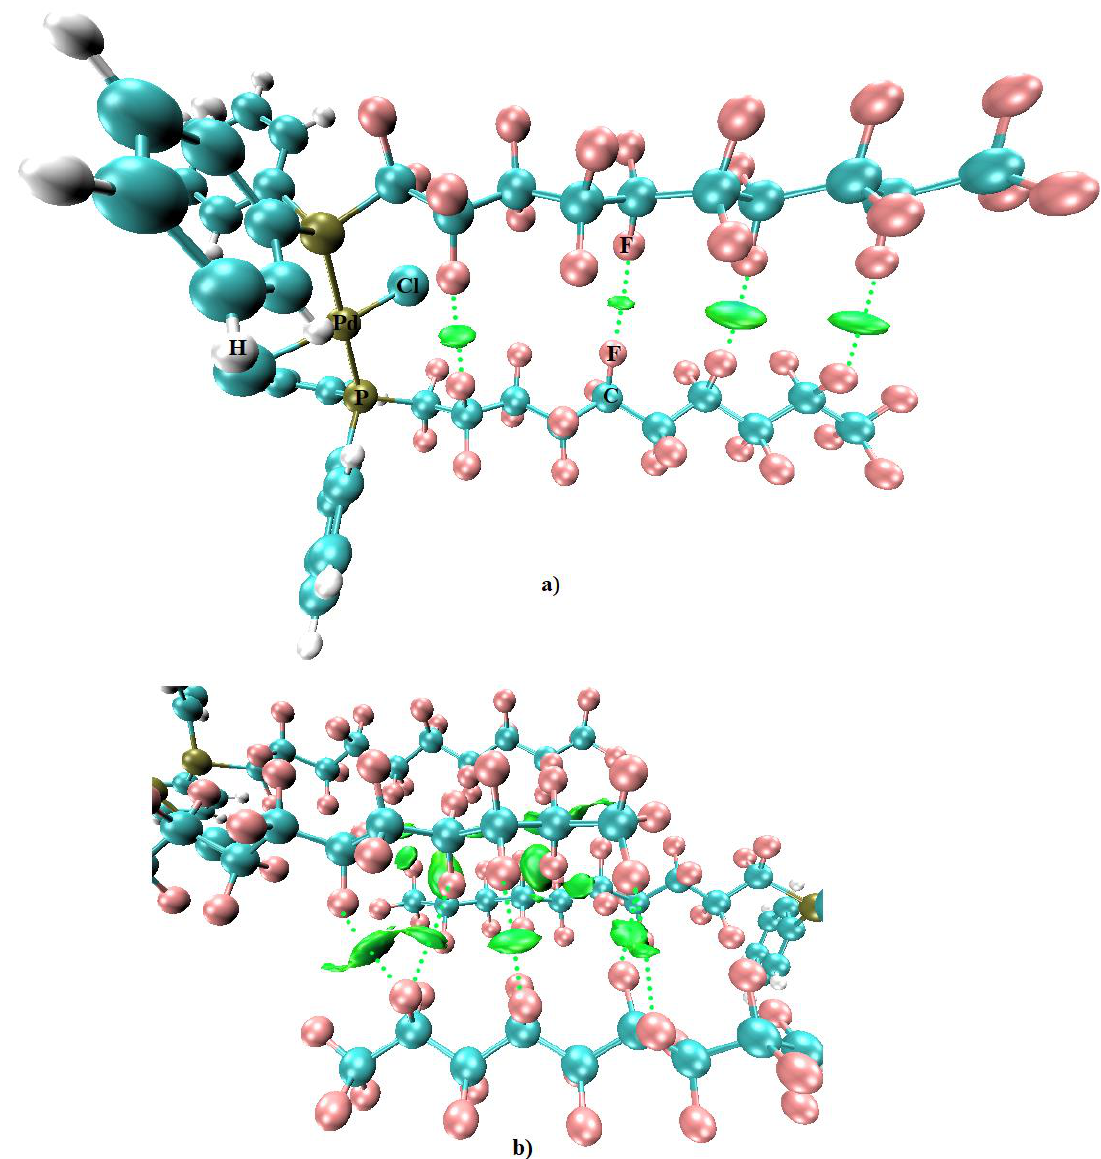
Figure 26. The IGM isosurface (0.005 a.u.) plot of the ( a ) dichloro-bis((henicosafluorodecyl)-(diphenyl)phosphine)-palladium(II) monomer and ( b ) that between the two monomers in the unit cell, showing potential F ⋯ F intra- and intermolecular interactions. The atom labeling is shown in ( a ).